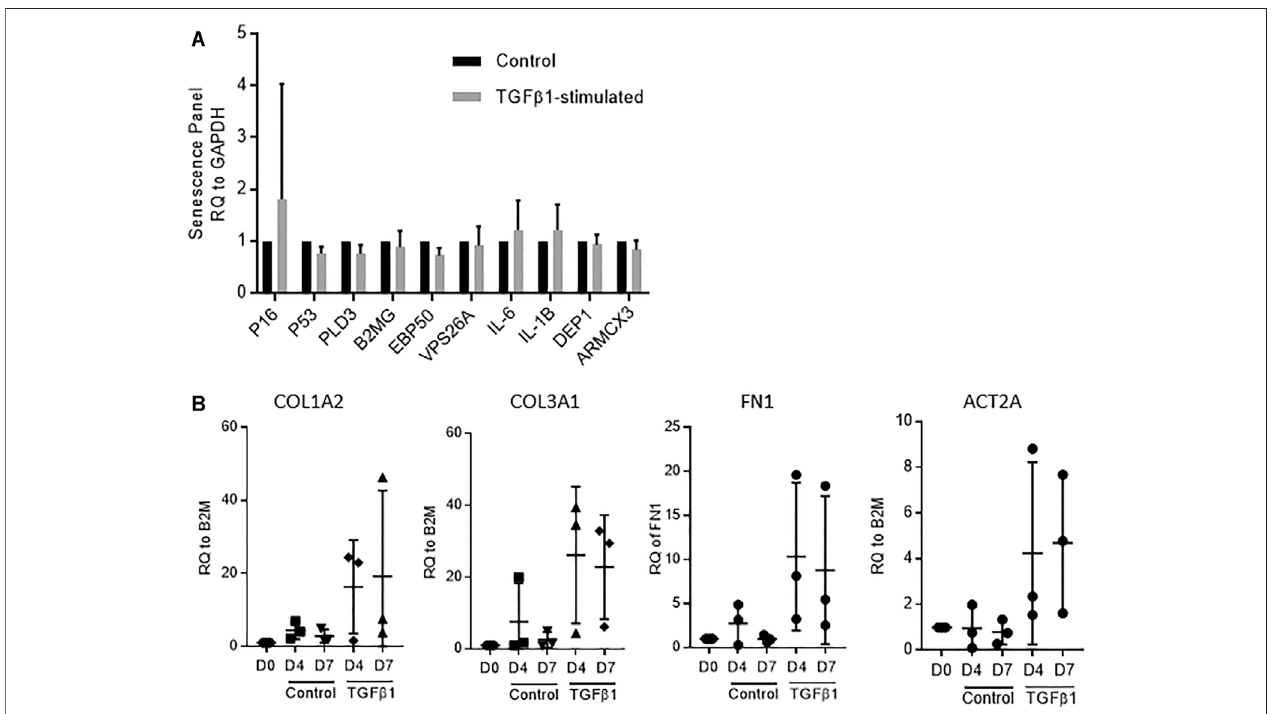
FIGURE 1 | (A) No evidence of cellular senescence was detected by RT-PCR in TGF β 1-stimulated tissue compared to matched controls using a panel of 10 diversesenescencemarkers( n (cid:1) 5donors). (B) Aselectionof fi broticmarkers,COL1A2,COL3A, FN1andACT2A quanti fi edbyRT-PCR, showedearly fi brotic changes in human TGF β 1-stimulated lung tissue as early as day 4, n (cid:1) 3.